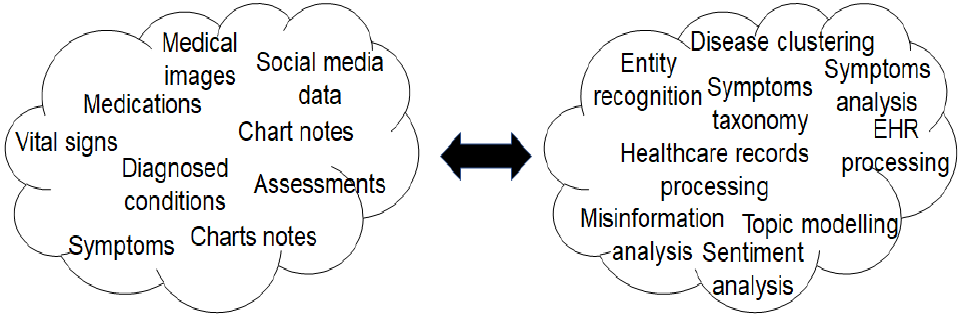
Figure 15. Applications and services of NLP technology in the context of COVID-19 (reformulated from